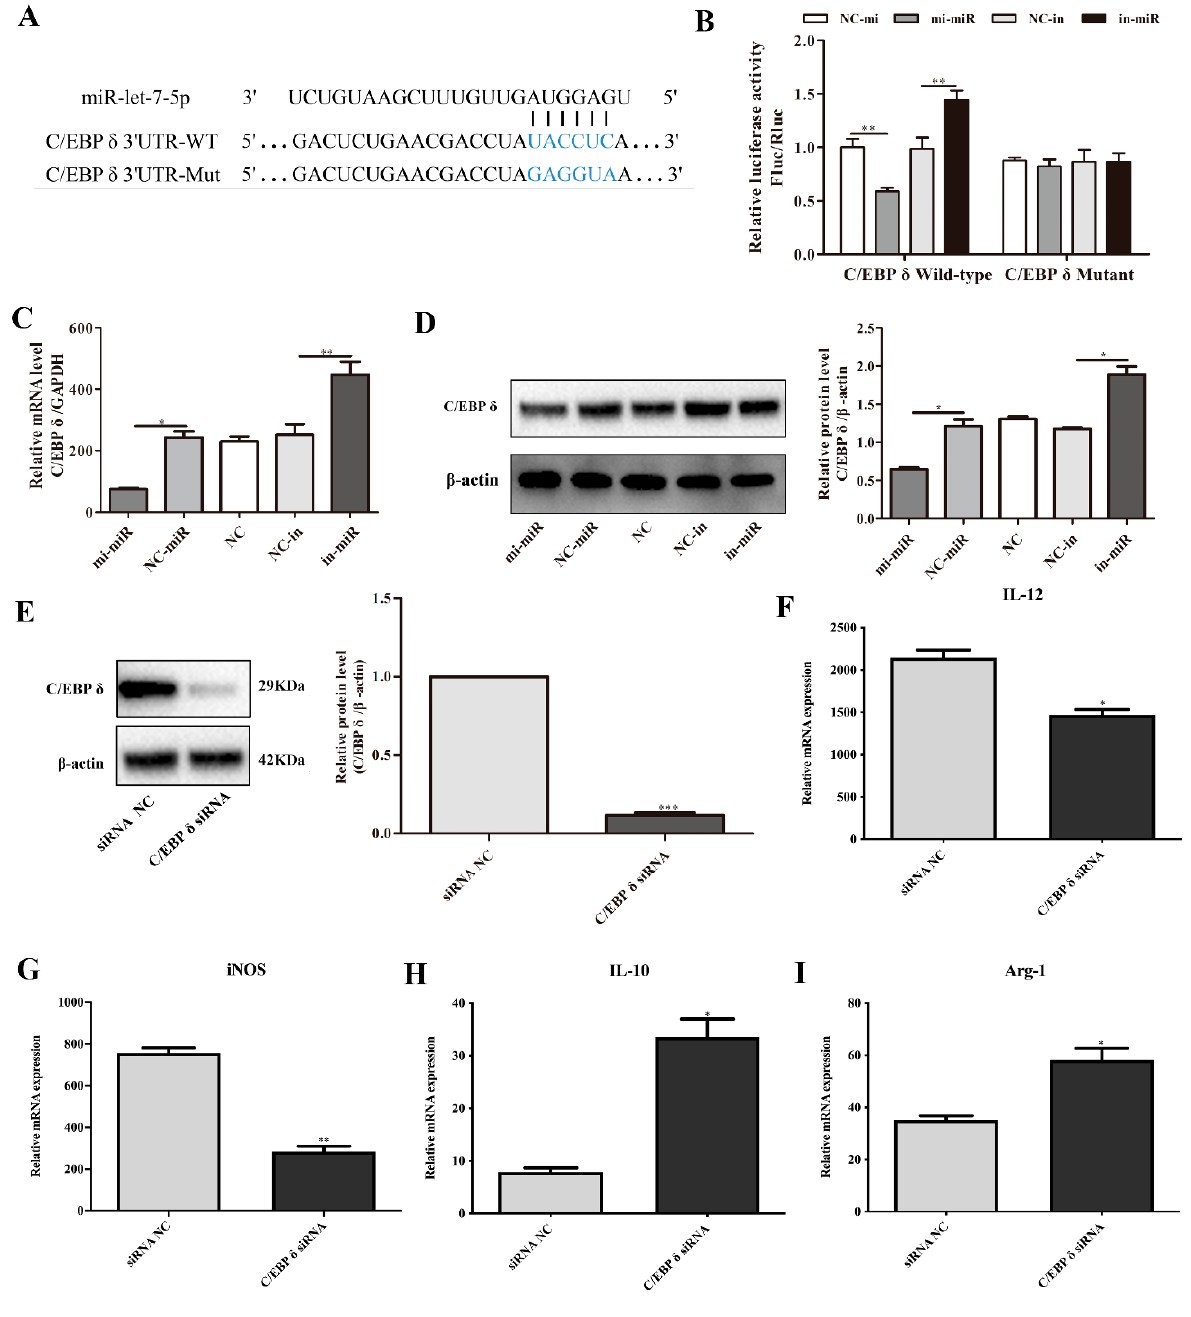
Figure 6. Exosomal miR-let-7-5p prompted M2 macrophage polarization via directly targeting C/EBP δ . ( A ) The predicted binding site between miR-let-7-5p and C/EBP δ 3 ′ UTR. ( B )The activities of luciferase reporters containing wild-type (WT) or mutant (MUT) C/EBP δ 3 ′ UTR were transfected into HEK293T cells that were then treated with miR-let-7-5p mimic, inhibitor, or control. ** p < 0.01 vs. the control group. ( C ) mRNA expression of C/EBP δ in macrophages after miR-let-7-5p mimic or control transfection. * p < 0.05 vs. the control group. ( D ) Western blot analysis of C/EBP δ in macrophages after miR-let-7-5p mimic or control transfection. * p < 0.05 vs. the control group. ( E ) Western blot analysis of C/EBP δ in macrophages after 50 nM siRNA or 50 nM siRNA control transfection. * p < 0.05 vs. the control group. ( F ) Levels of IL-12 were determined by qPCR. ( G ) Levels of iNOS were detected by qPCR. ( H ) Levels of IL-10 were assessed by qPCR. ( I ) Levels of Arg-1 were evaluated by qPCR. n = 3, mean ± SD, * p < 0.05, ** p < 0.01, *** p < 0.001 vs. the control